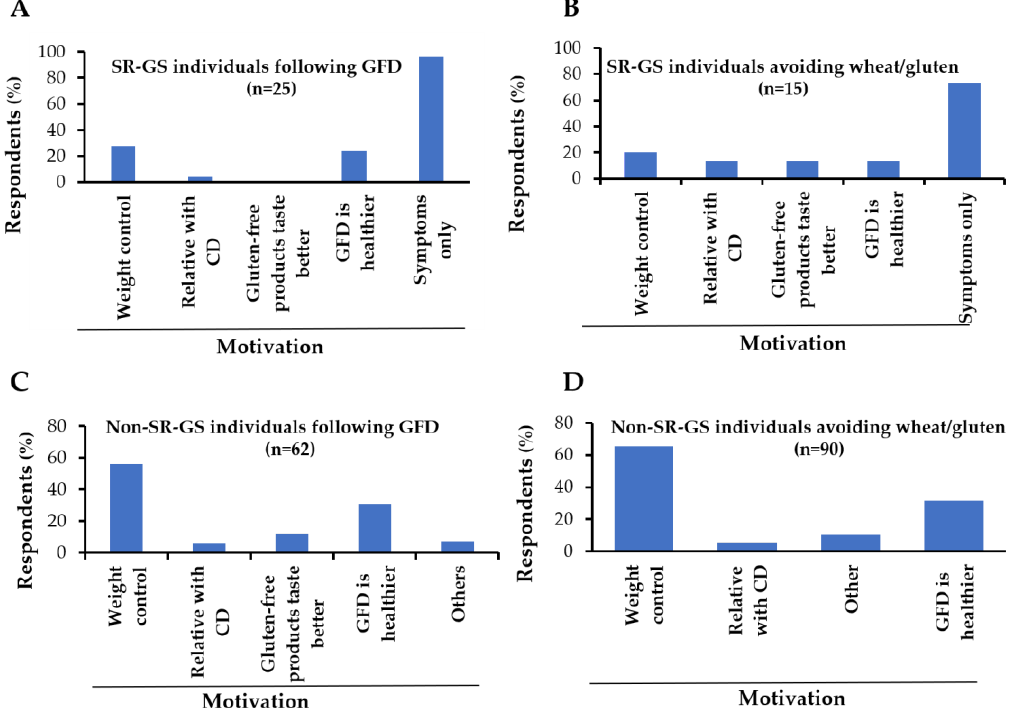
Figure 4. Motivations for following a gluten-free diet (GFD) or avoiding wheat/gluten from the diet. ( A , B ) motivations of Self-Reported Gluten Sensitivity (SR-GS) cases for following a GFD, ( C , D ) motivations of non Self-Reported Gluten Sensitivity (non-SR-GS) cases for avoiding wheat/gluten